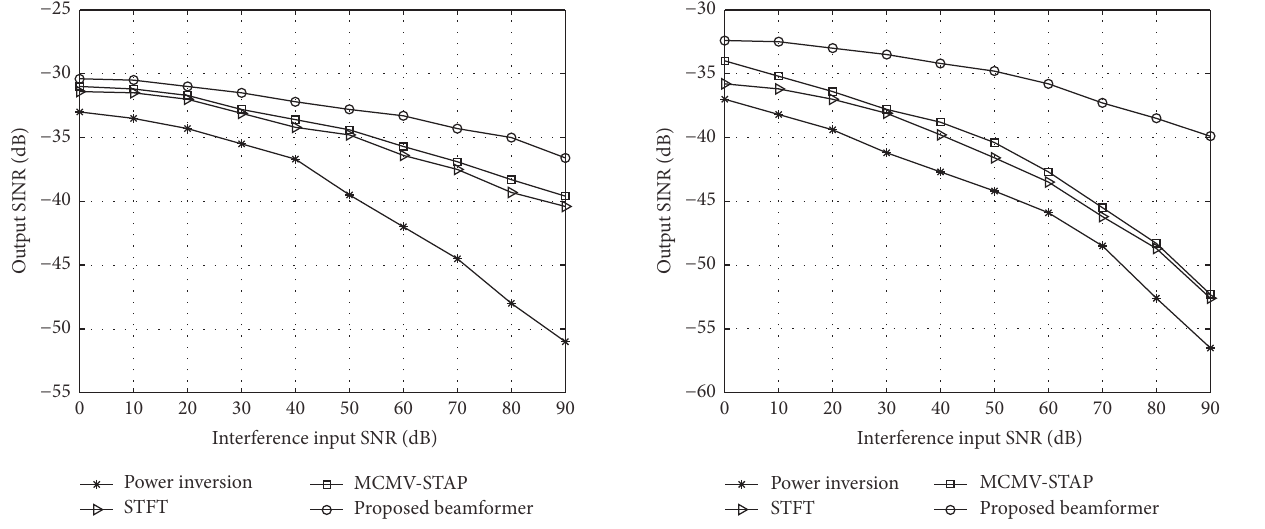
Figure 8: The output SINR of different method when suppress jamming: the angle of arrival of the satellite signal is 0 degrees and the angle of arrival of jamming signal is − 6 degrees.